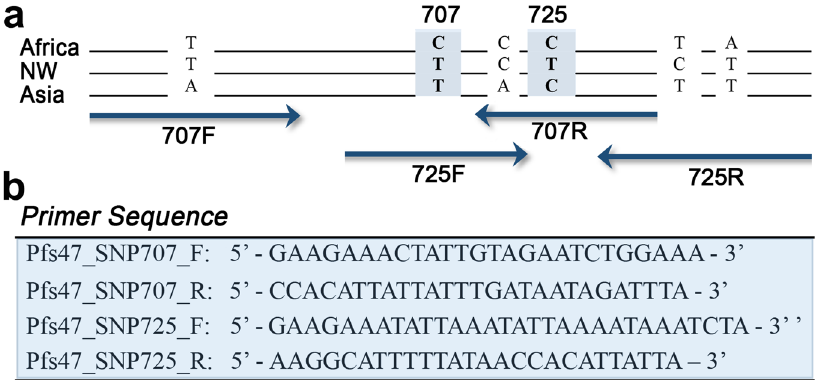
Fig. 2 Pfs47 polymorphisms near SNPs 707 and 725 and High-Resolution Melting assay (HRM) primer design. a Schematic representation of Pfs47 polymorphisms in representative haplotypes of P. falciparum isolates from Africa (GB4), New World (7G8), and Asia (Asia 33). The diagram illustrates the approximate location of the forward and reverse primers for HRM assays to genotype SNPs at 707 and 725. b Primer sequences used in HRM